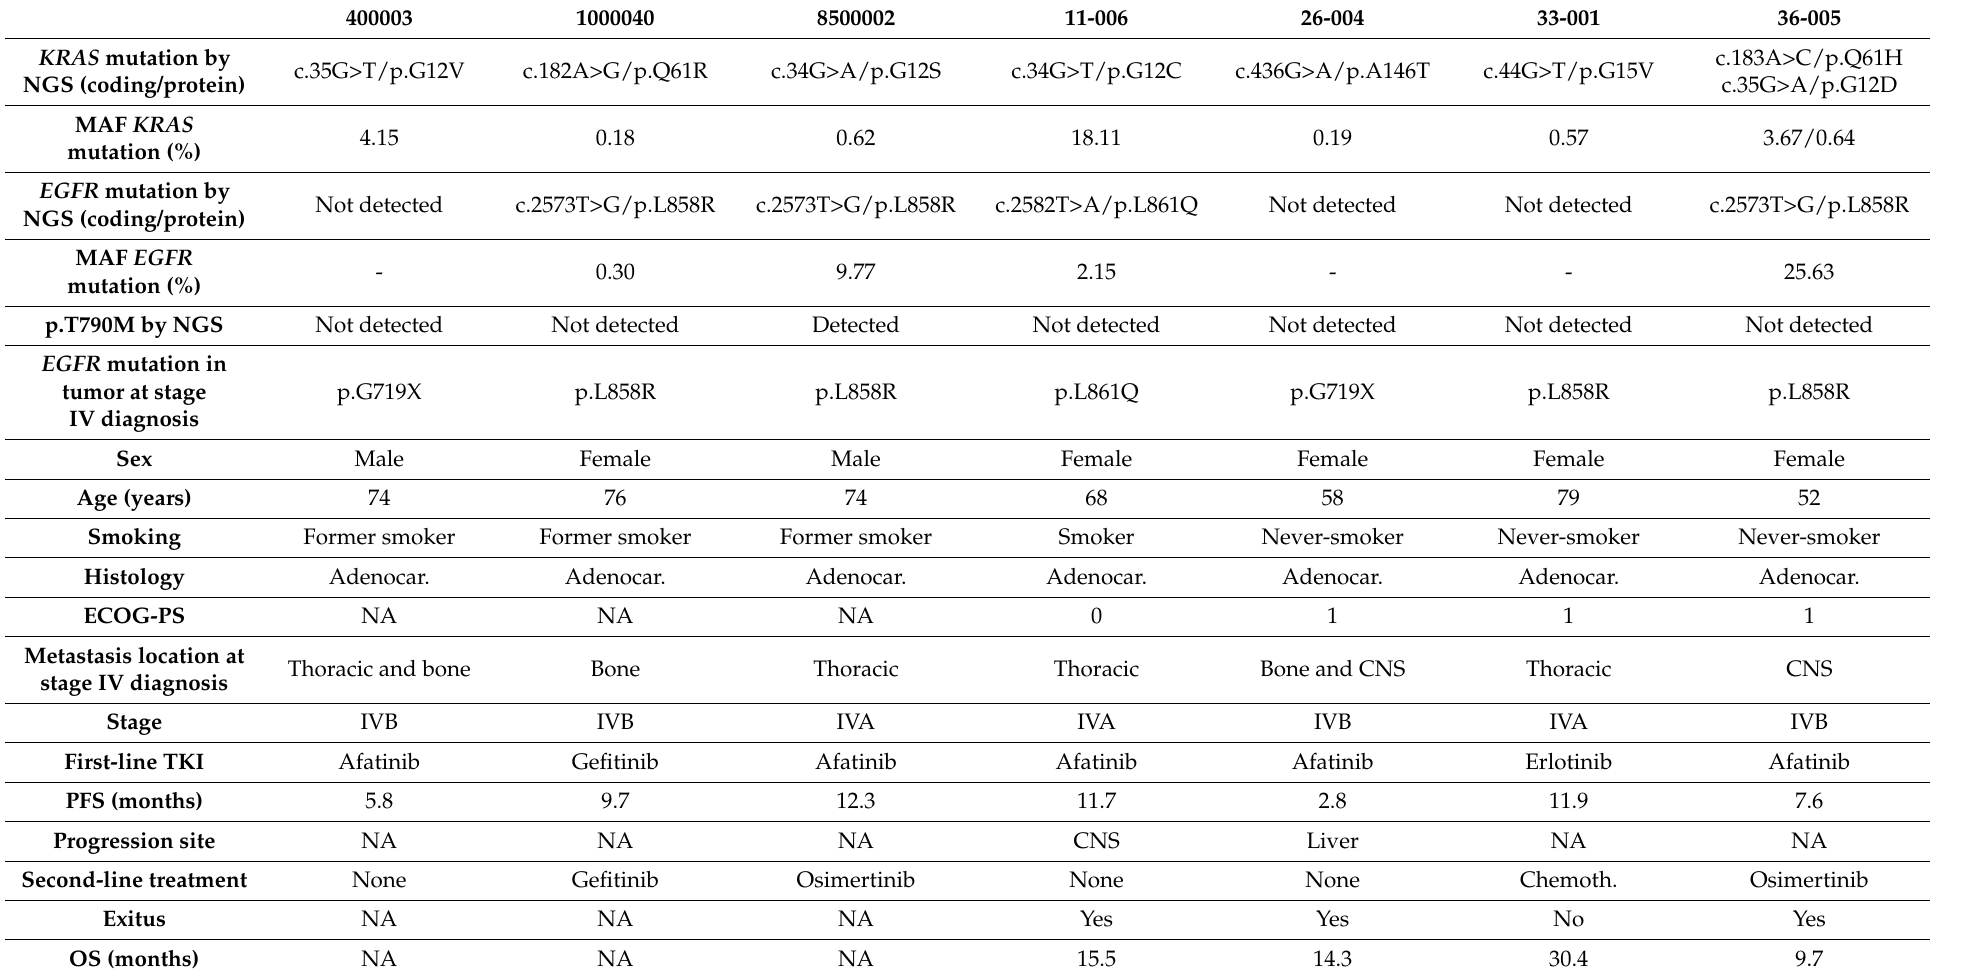
Table 3. Clinicopathological features of KRAS mutated